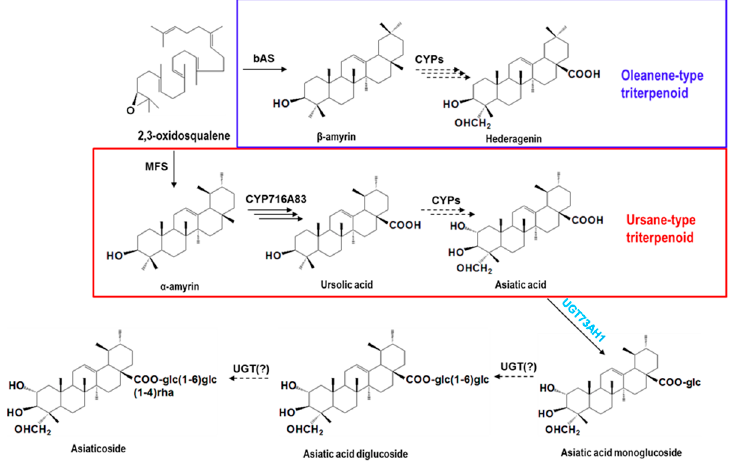
Figure 1. Putative biosynthetic pathway leading to triterpene saponins in Centella asiatica . The precursors, β -amyrin and α -amyrin, are converted by a series of oxidative reactions to oleanene- and ursane-type aglycones, respectively. In the ursane-type triterpenoid pathway, asiatic acid is converted by UDP-glucosyltransferases (UGTs) to asiaticoside. The following enzymes are represented: bAS, β -amyrin synthase; MFS, multifunctional triterpene synthase; CYP716A83, C-28 oxidase; CYPs, cytochrome P450 monooxygenases; UGT73AH1, 28- O -glucosytransferase.